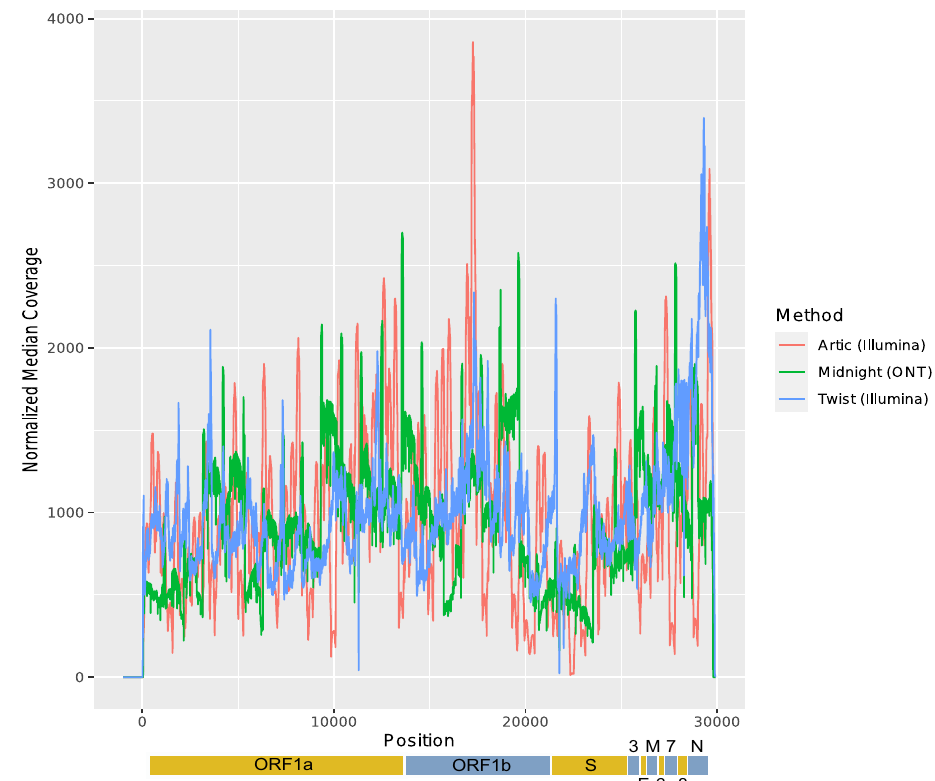
Figure 2. Mean sequencing coverage of the SARS‑CoV‑2 genome for each method. Sequencing depths are scattered along the SARS‑CoV‑2 genome, and the line for each method represents coverage of the raw medians for every position. Read coverage is normalized so that mean coverage is 1000 × for every sample. SARS‑CoV‑2 open reading frames (ORFs) are shown below the graph: 3, ORF3; 6, ORF6; 7, ORF7; 8,